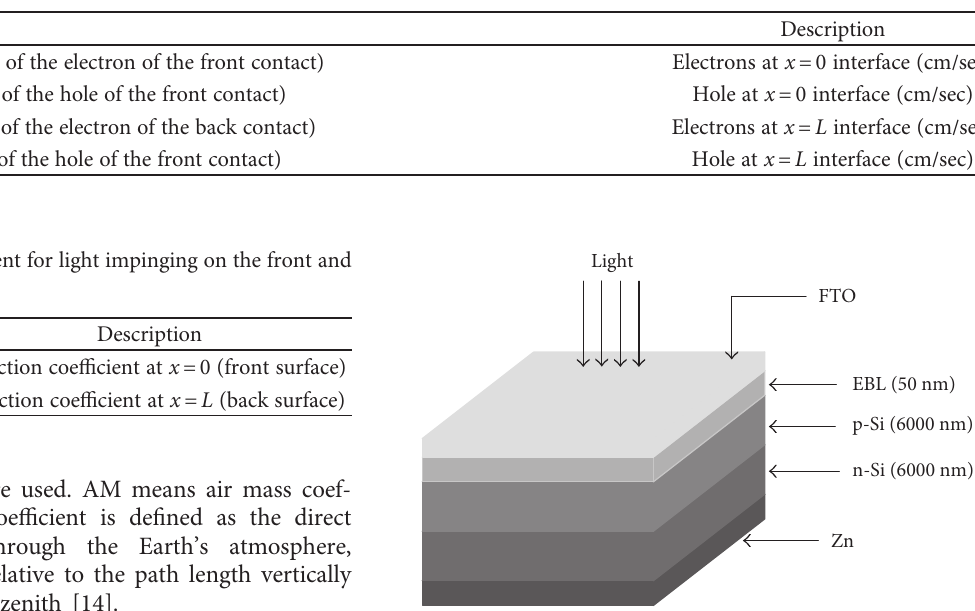
Table 2: Surface recombination speed of AMPS.